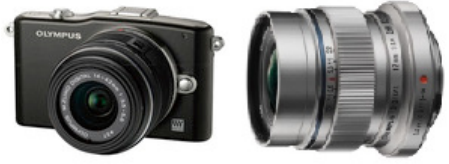
Figure 3. Olympus PEN E-PM1 and M.Zuiko 12mm f/2